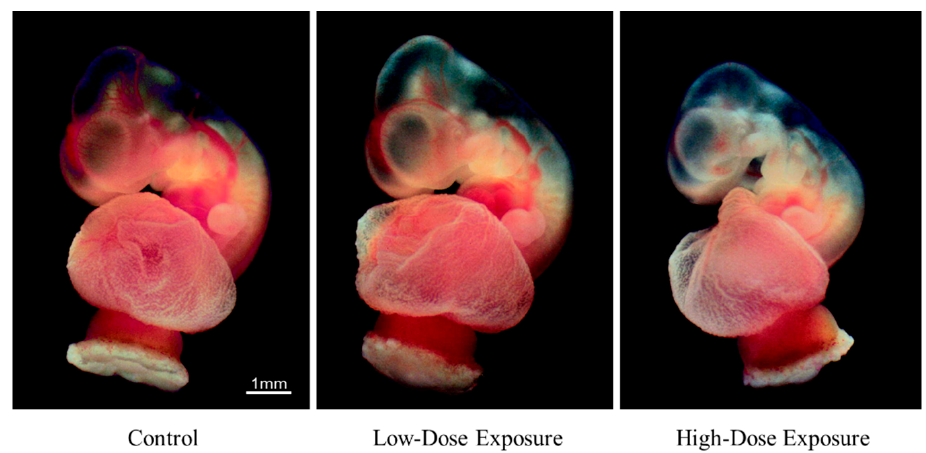
Figure 3. Morphological changes in rat embryos cultured for 24 h with low- and high-dose organo- halogen contaminants from whale bacon. Whole cultured rat embryos with placenta and yolk sac. Scale bar = 1 mm.